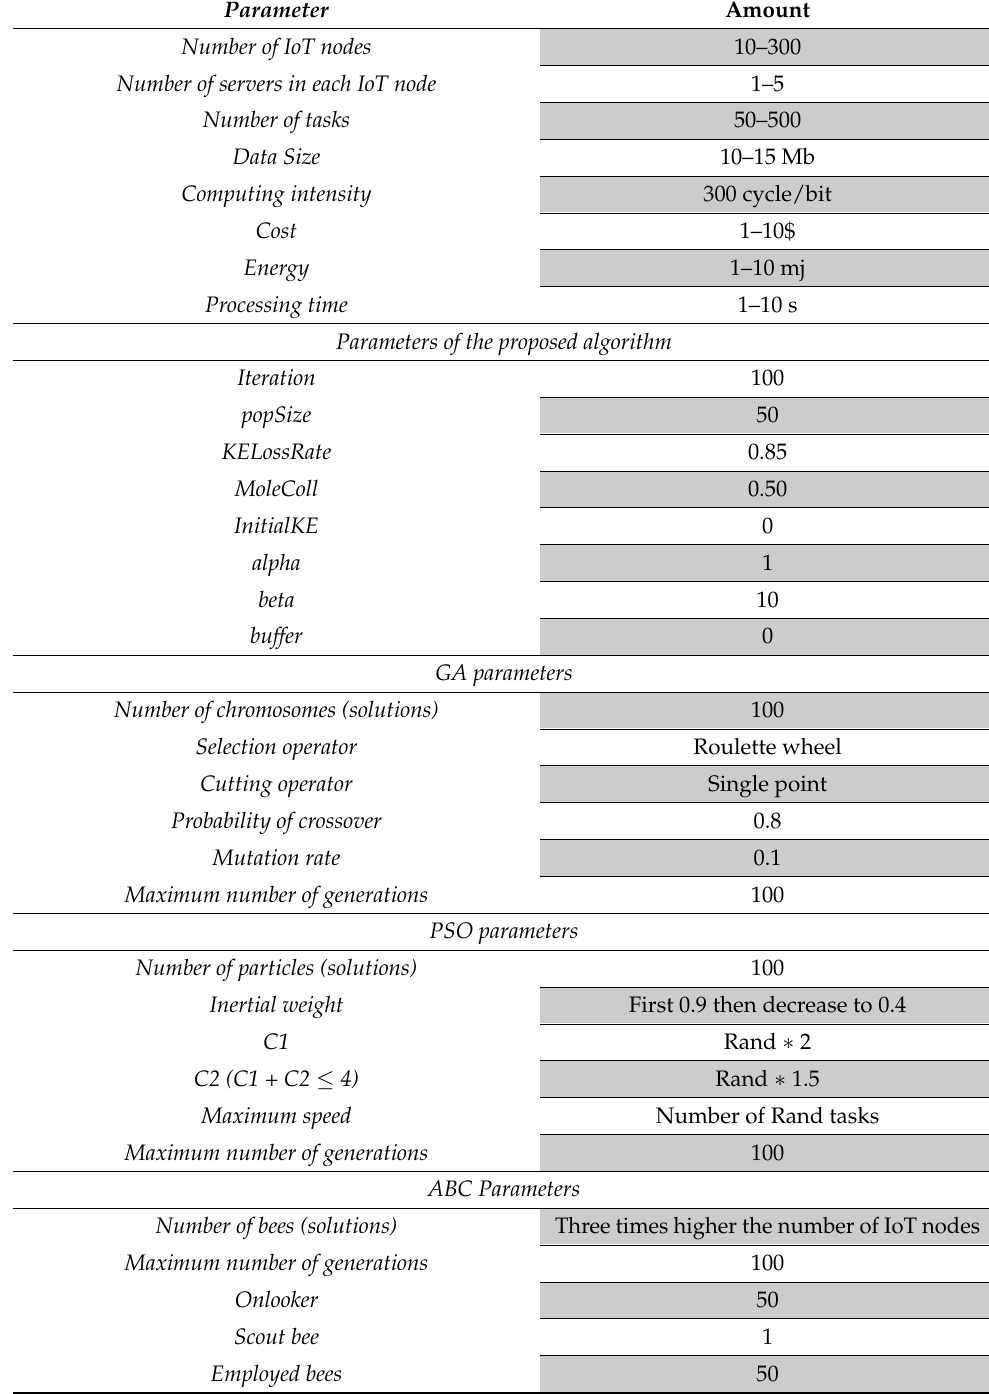
Table 2. Simulation